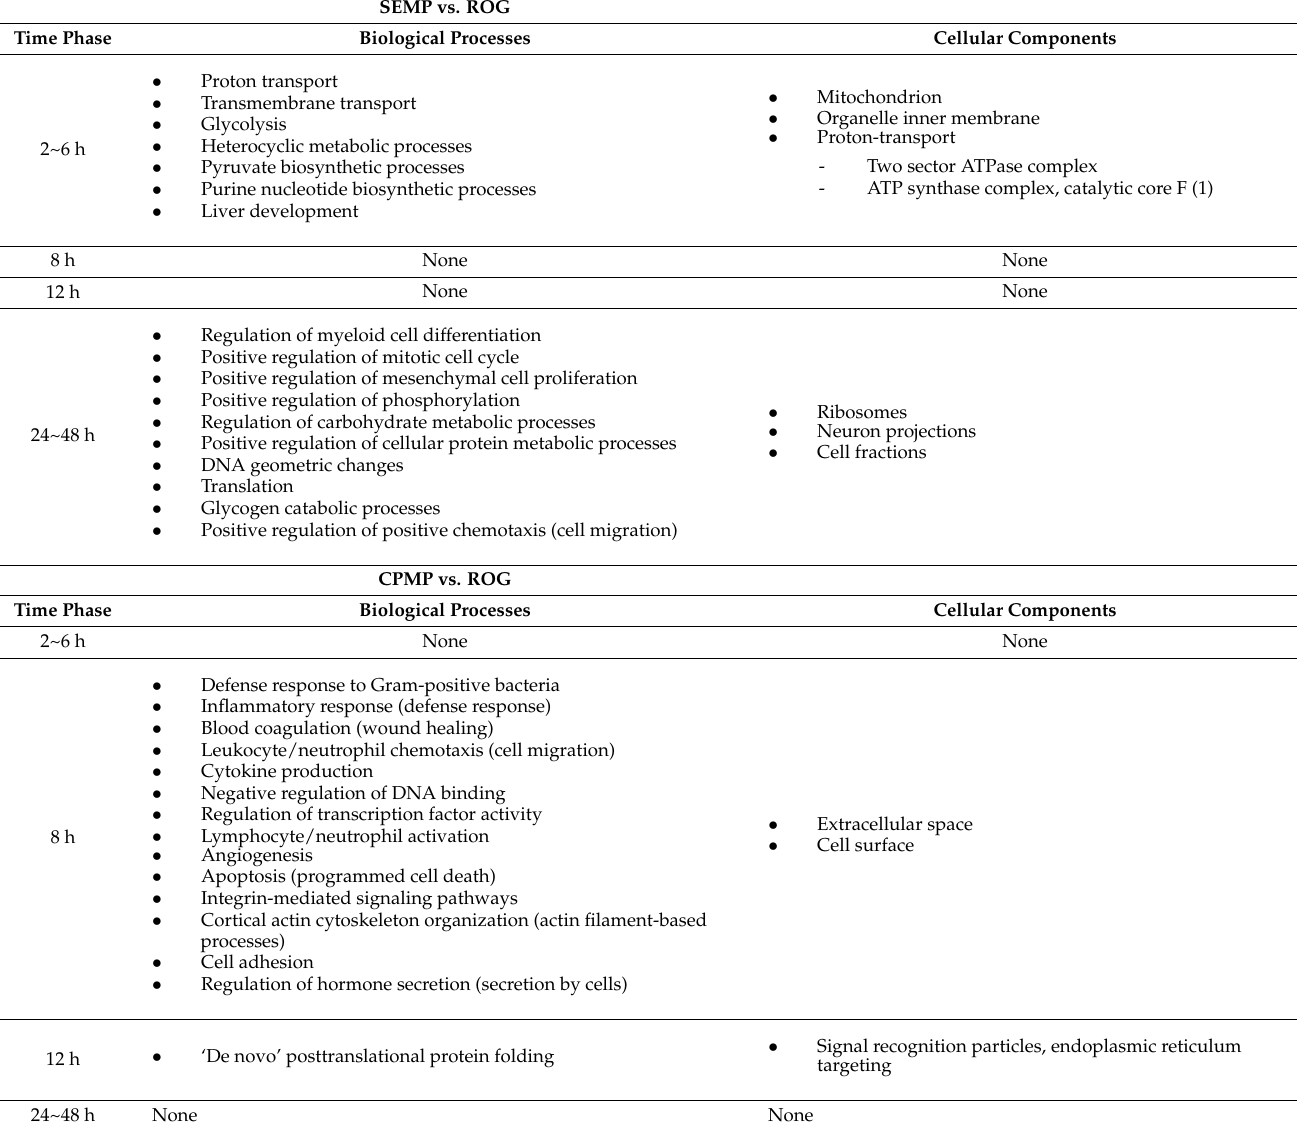
Table 5. List of the most representative and statistically significant gene ontology terms (biological processes and cellular components) of each gene class of SEMP, CPMP, and ICMP at different time